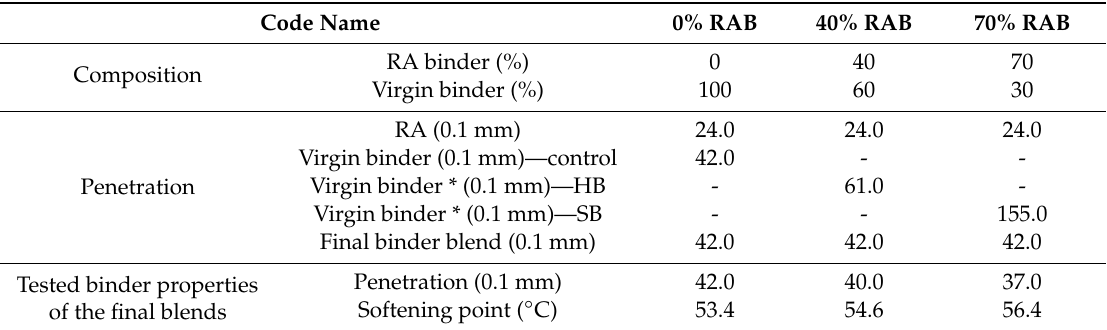
Table 3. Theoretical binder mix design and measured conventional properties of the final binder blends.